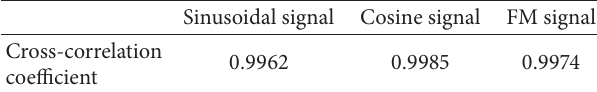
Table 1: The cross-correlation coefficient of reconstruction signal.